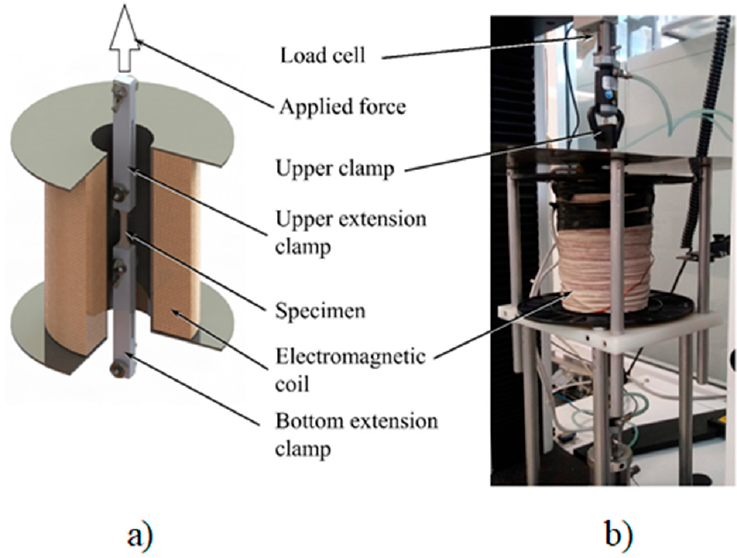
Figure 17. ( a ) Schematic representation of the solenoid, extension clamps, and specimen. ( b ) Uniaxial tensile machine coupled with a solenoid coil to perform the cyclic tensile test under a magnetic field.